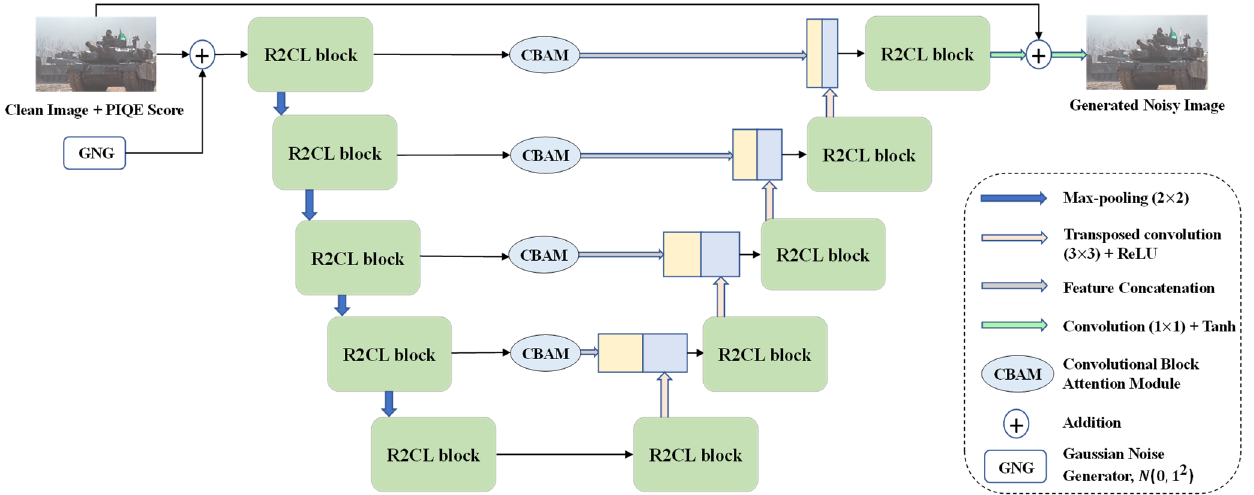
Figure 3. Generator architecture containing convolutional encoding and decoding units based on the recurrent residual convolutional layer (R2CL) and convolutional block attention module (CBAM) replacing the skip connection. GNG denotes the gaussian noise generator initially generating input random vector that is spatially repeated to the clean image.